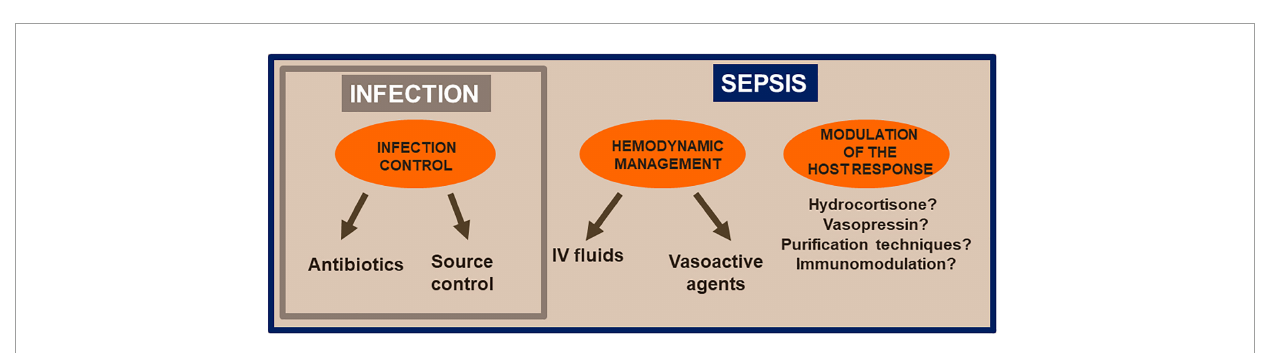
FIGURE1 The pyramid of severity in infection.